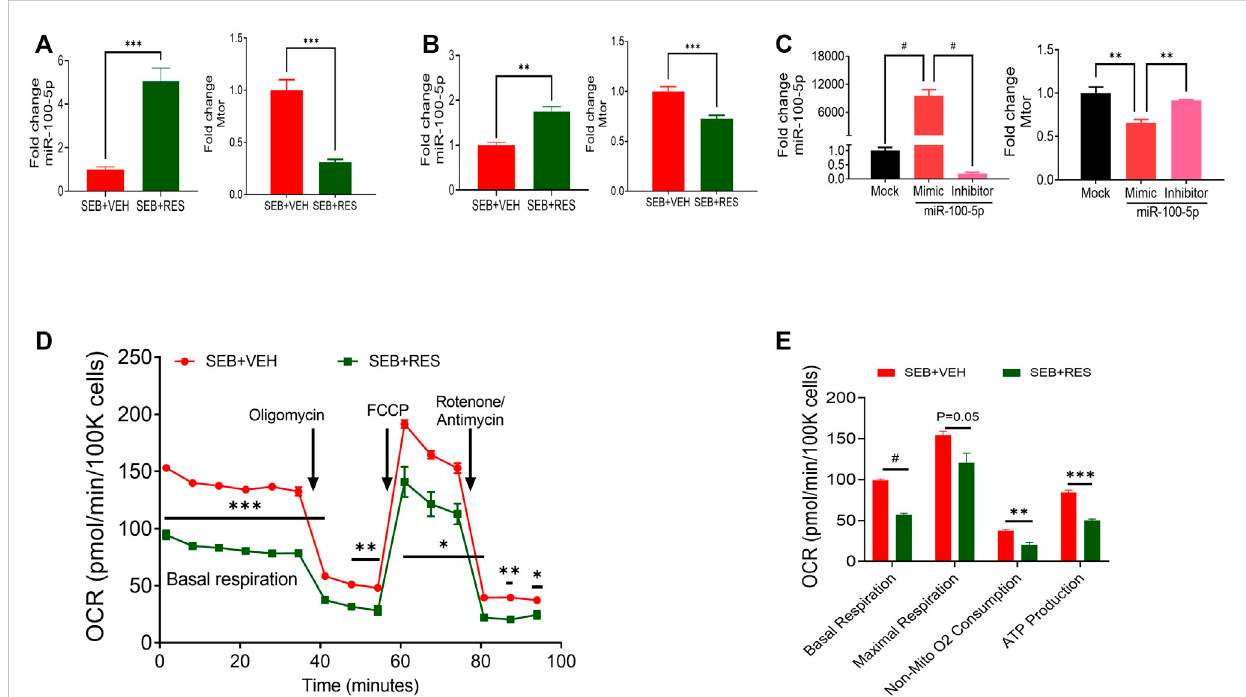
FIGURE 2 Invivo and invitro treatmentofRESleadstosuppressionofmTORgeneexpressionviaupregulationofmiR-100anddecreasedenergyproductionin SEB-activatedTcells . MiceweretreatedwithSEBandRESasdescribedinFigure 1. (A) q-RT-PCRshowingthelevelsofexpressionofmiR-100andmTOR genes in the lung MNCs. (B) q-RT-PCR analysis of miR-100 and mTOR gene expression in PE-selected CD3 + cells puri fi ed from splenocytes activated with SEBand treated withVEH orRES. (C) q-RT-PCR analysis ofmiR-100and mTOR geneexpression intransfectedSEB-activatedsplenocyteswith miR-100 mimic siRNA or inhibitor compared to mock-treated group. (D) . Real-time analysis of mitochondrial respiration in T cells by using Seahorse system in presence of oligomycin, Carbonyl cyanide-4-phenylhydrazone (FCCP) and combination of rotenone and antimycin. (E) . Quanti fi cation of selectedCD3 + Tcellrespiratorykineticscalculatedbyreportgeneratorsoftwarebasedonchangesinoxygenconsumptionrate(OCR)measuredinpanel (D) .Comparedvalues represent mean±standarderrorofmeans(M±SE). One-way ANOVAtestwithmultipleTukey ’ scorrectionwasappliedto compare more than two groups. T-test was applied with Holm-Sidak correction method to compare two groups. p < 0.05 considered as signi fi cant